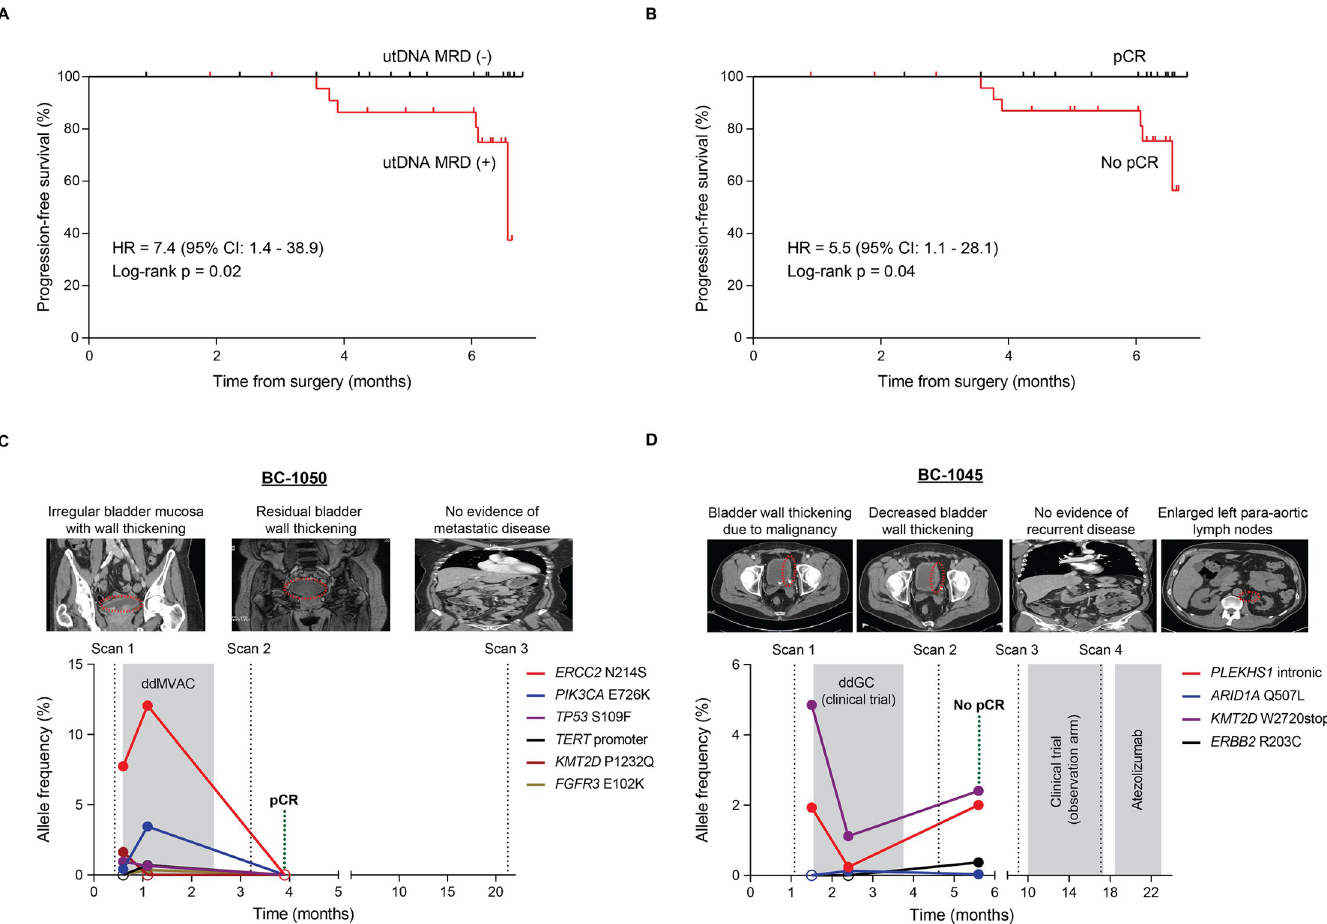
Fig 4. Preoperative utDNA MRD as an early prognostic biomarker in localized bladder cancer patients. (A) Kaplan–Meier analysis of PFS stratified by preoperative utDNA MRD detection and (B) pathologic response after radical cystectomy. utDNA MRD (+) patients had significantly worse PFS than utDNA MRD ( − ) patients (HR = 7.4; 95% CI: 1.4–38.9; p = 0.02). Patients with no pCR also had significantly worse PFS than patients with pCR (HR = 5.5; 95% CI: 1.1–28.1; p = 0.04). HRs and p - values were calculated using the Mantel–Haenszel and Mantel–Cox tests, respectively. (C) Serial urine cfDNA analysis for MIBC patient BC-1050. Imaging after neoadjuvant chemotherapy was equivocal with residual bladder wall thickening. utDNA levels increased during neoadjuvant chemotherapy with a COSMIC- and OncoKB-annotated nonsynonymous ERCC2 mutation having the highest VAF. utDNA levels then decreased and became undetectable at the preoperative MRD time point, concordant with pCR on surgical pathology. The patient remained disease free on long-term follow-up. (D) Serial urine cfDNA analysis for MIBC patient BC- 1045. Imaging after neoadjuvant chemotherapy noted decreased but persistent bladder wall thickening. utDNA levels decreased during neoadjuvant chemotherapy, with a KMT2D stop–gain mutation having the highest VAF. utDNA levels then increased at the preoperative MRD time point with evidence of 2 new emergent nonsynonymous mutations in ERBB2 and ARID1A , not present earlier. Consistent with this positive utDNA MRD result, the patient had pathological nodal involvement despite achieving a pCR in the urothelium, and, less than a year later, developed progressive disease that prompted the start of treatment with atezolizumab. cfDNA, cell-free DNA; CI, confidence interval; COSMIC, Catalogue of Somatic Mutations in Cancer; HR, hazard ratio; MIBC, muscle-invasive bladder cancer; MRD, minimal residual disease; pCR, pathologic complete response; PFS, progression-free survival; utDNA, urine tumor DNA; VAF, variant allele